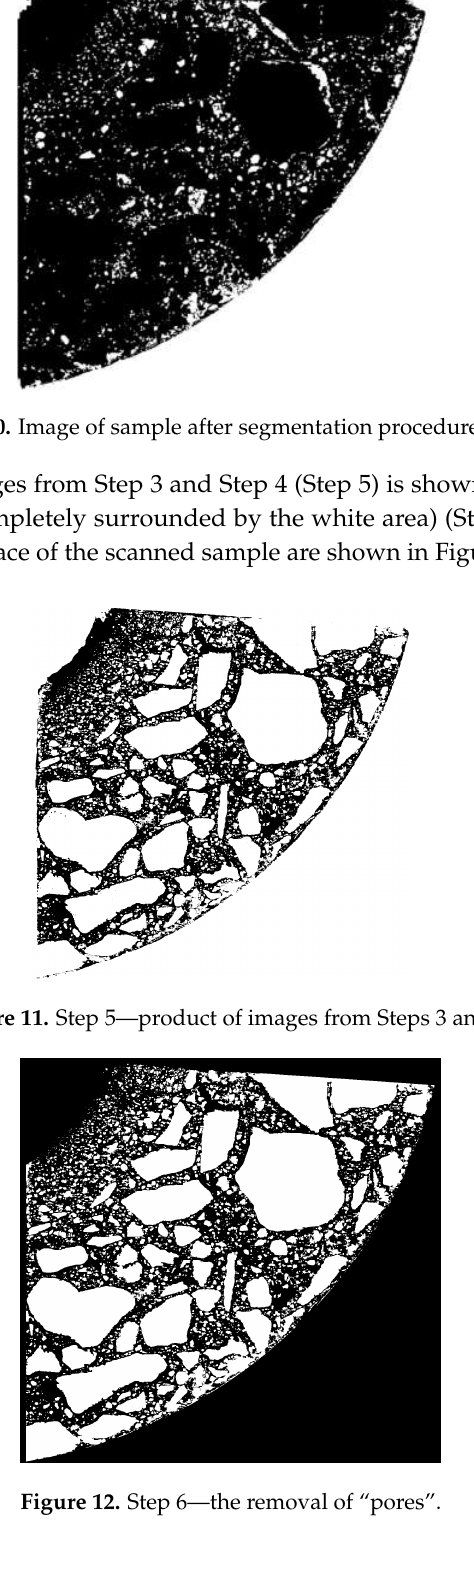
Figure 9. Superimposition of masks created from red (R) and blue (B) channels.